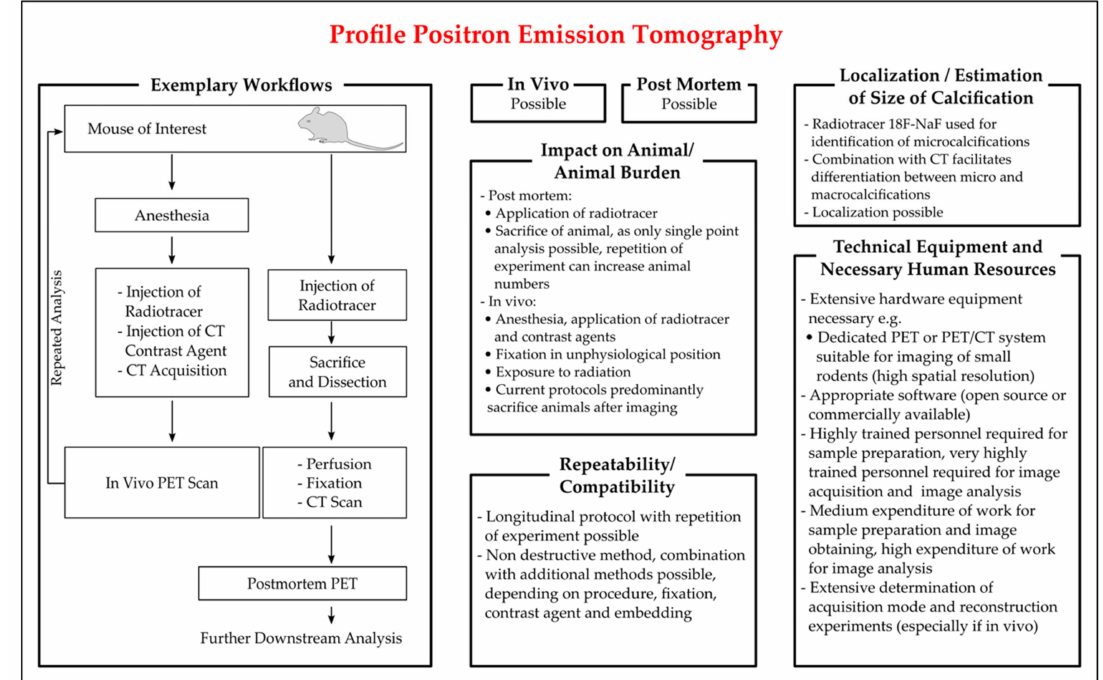
Figure 4. Characteristics of protocols of positron emission tomography (PET) employed for the detection of vascular calcification in mice. Key aspects for the critical appraisal of the applicability of PET are summarized with regards to the applicability of PET in vivo and ex vivo, the location and size of VC identifiable by PET, the repeatability of analysis in longitudinal studies, the compatibility with additional methods, and the personal and technical expanse. The exemplary workflow presented is based on the publications of